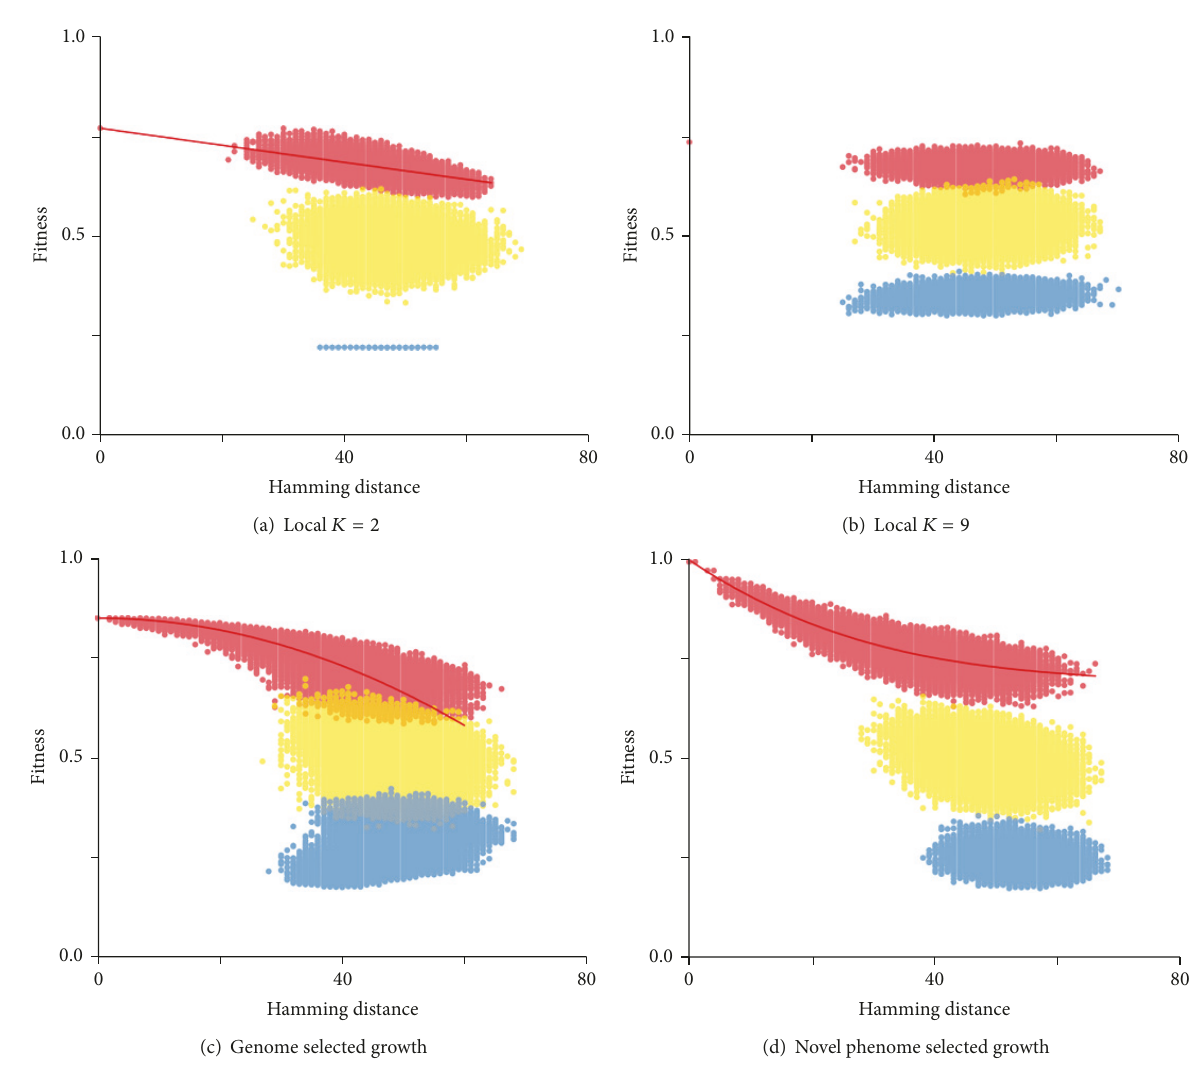
Figure 4: Hamming distance from fittest optima comparison: red points are the hamming distance from fittest optima found to other optima found over 100,000 adaptive walks. Yellow points are the hamming distance from fittest optima found to 100,000 randomly generated sequences. Blue points are the hamming distance from fittest optima found to the minima found over 100,000 downhill adaptive walks. (a) 𝐾 = 2 local landscape; (b) 𝐾 = 8 local landscape; (c) Genome selected landscape; (d) Phenome selected